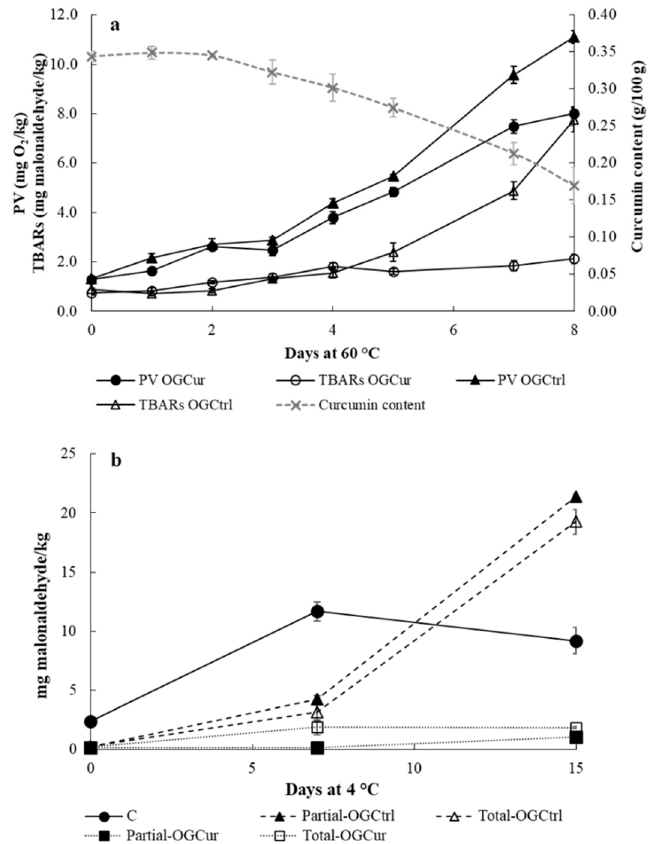
Figure 5. ( a ) Evolution of peroxide values (PV), TBARs values (TBARs) and curcumin content in OGCur and OGCtrl during accelerated oxidation conditions (60 ◦ C). ( b ) TBARs values in p â t é s with di ff erent lipid ingredients used in the formulation during chilled storage (C, p â t é with pork backfat; Partial-OGCur, p â t é with partial replacement of pork backfat by OGCur; Partial-OGCtrl, p â t é with partial replacement of pork backfat by OGCtrl; Total-OGCur, p â t é with total replacement of pork backfat by OGCur; Total-OGCtrl, p â t é with total replacement of pork backfat by